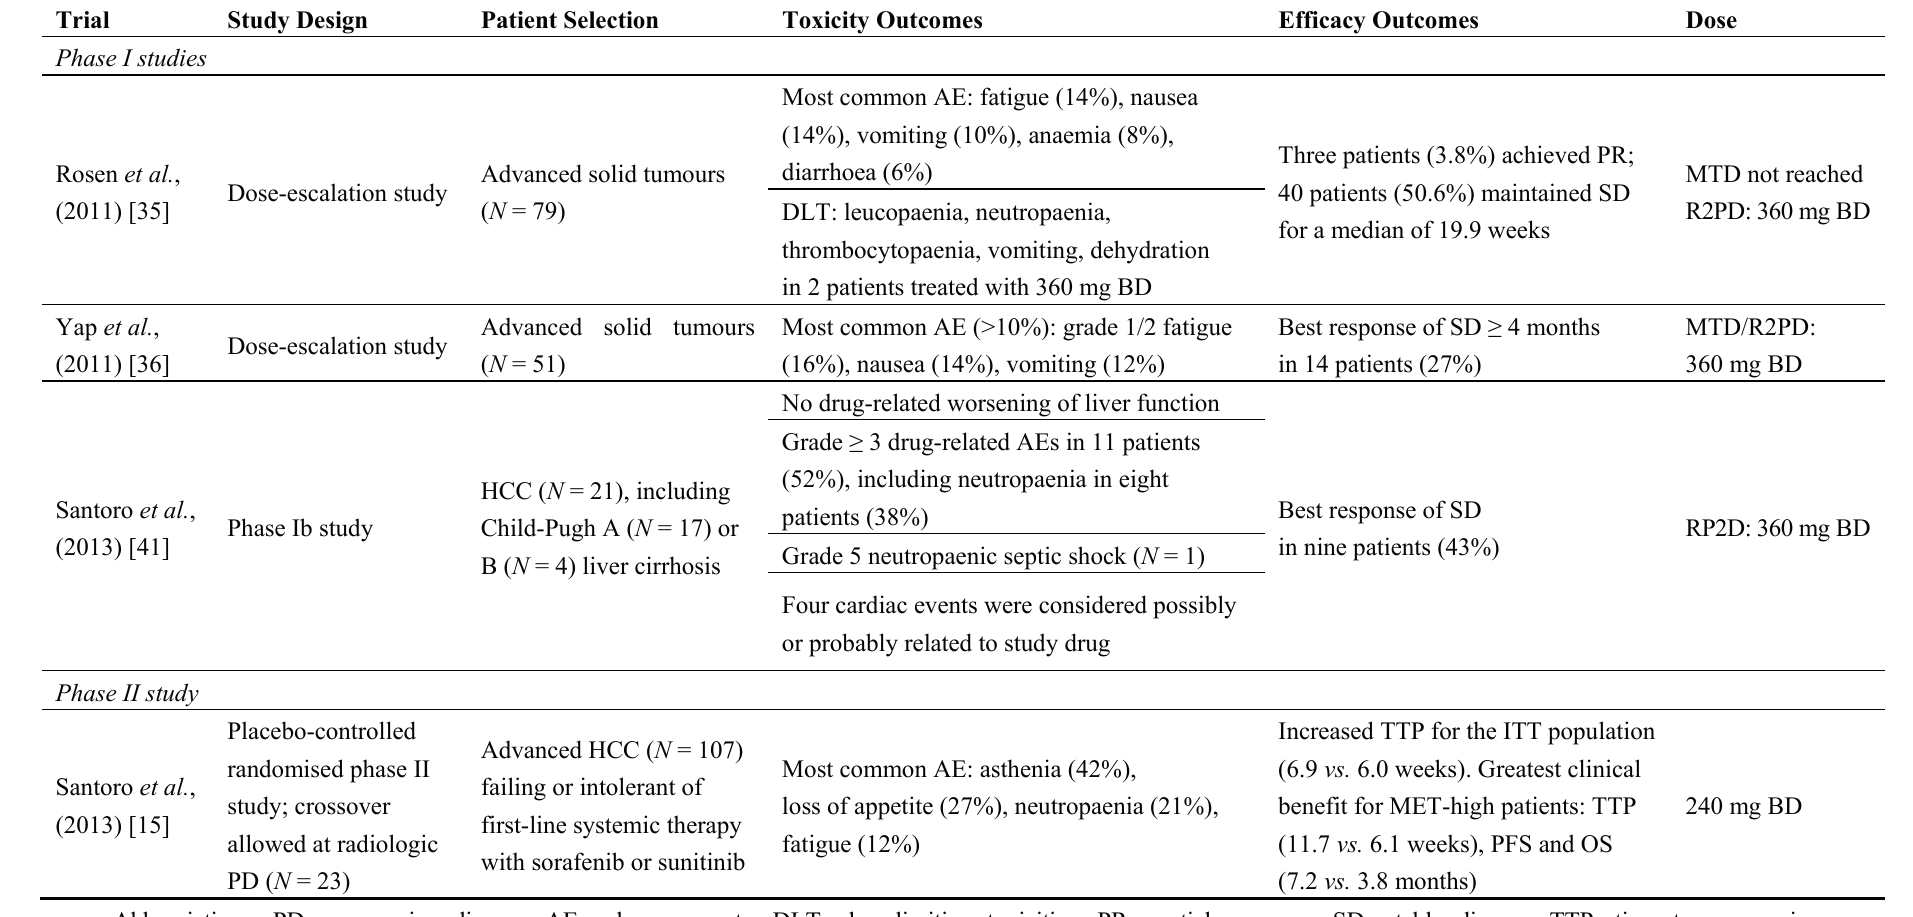
Table 3. Selected phase I and II clinical trials of Tivantinib monotherapy in HCC (adapted from Rimassa et al. [44]).